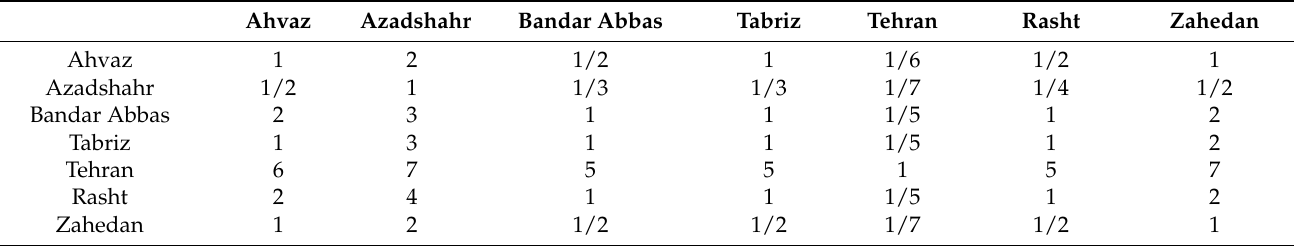
Table 7. Pairwise comparison matrix of alternatives with respect to IPBP.